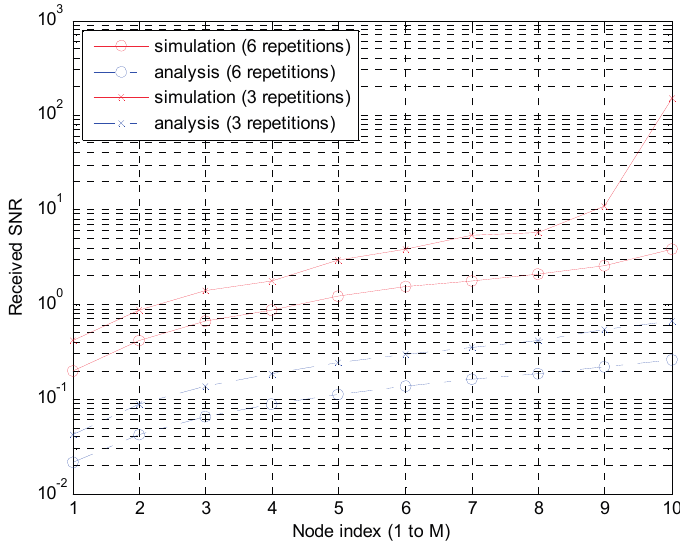
Figure 16. Power levels according to the node by the simulation and analysis in Scheme